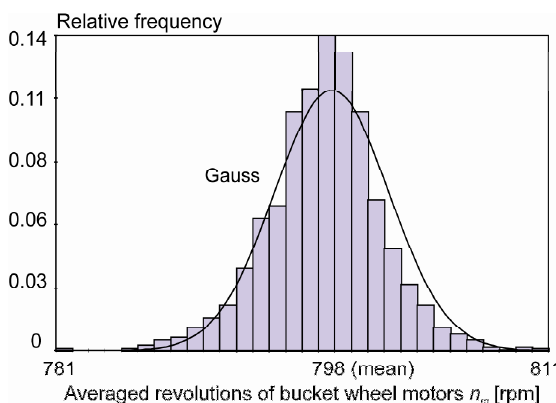
Fig. 6. Histogram of revolutions of bucket wheel motors